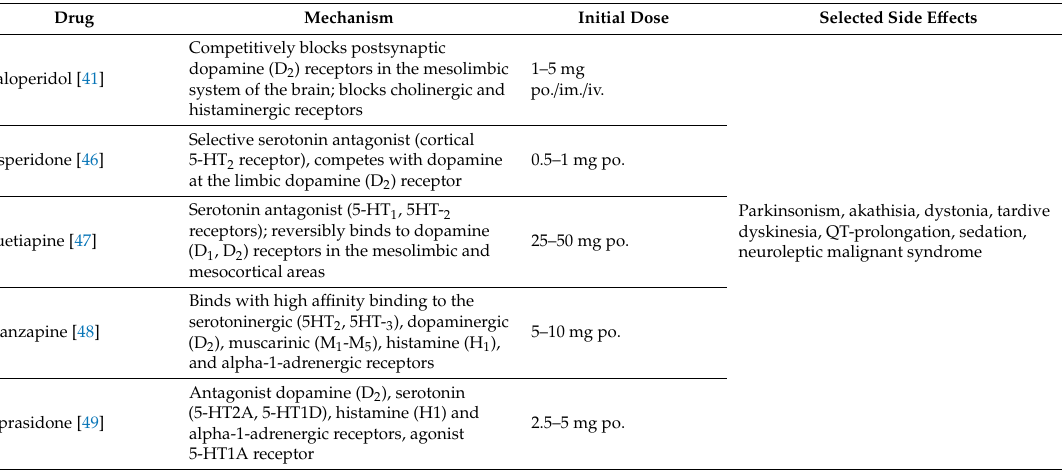
Table 2. Characteristics of antipsychotic